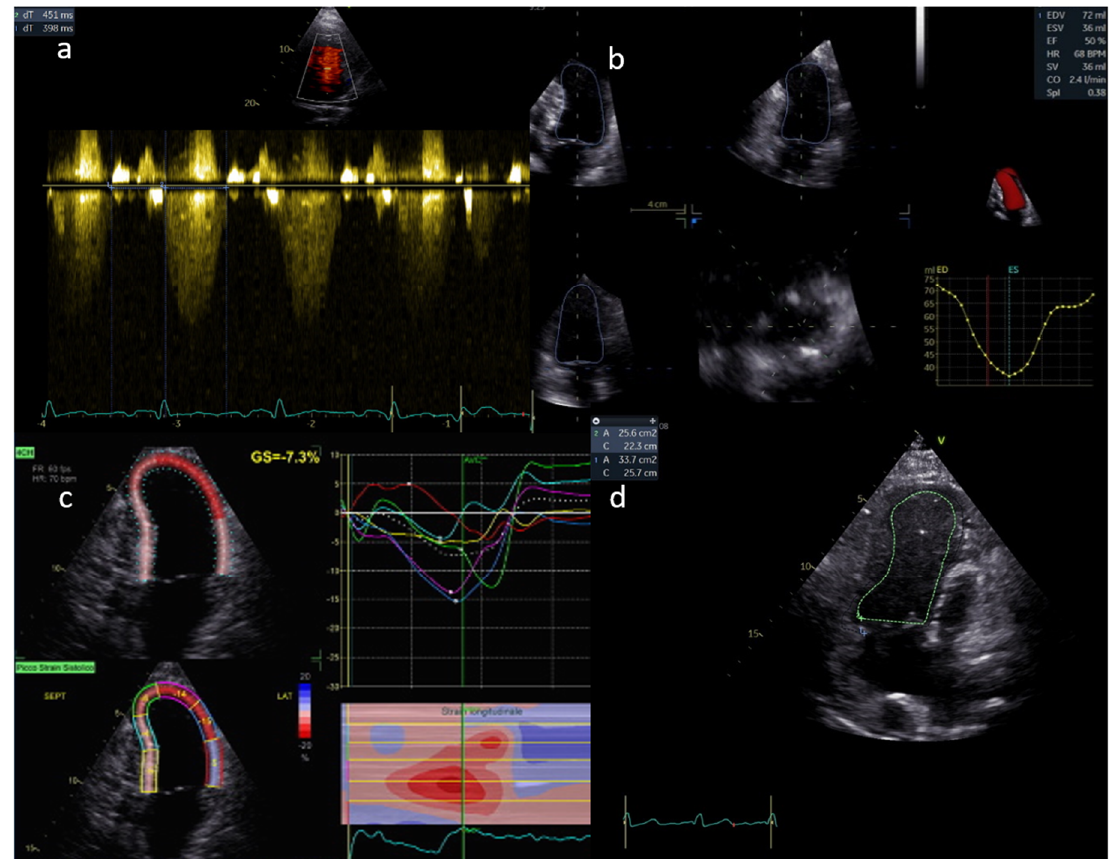
Figure 1. Ventricle function is assessed in a , b , c and d by AV S/D, 3D EF, LS, and FAC,